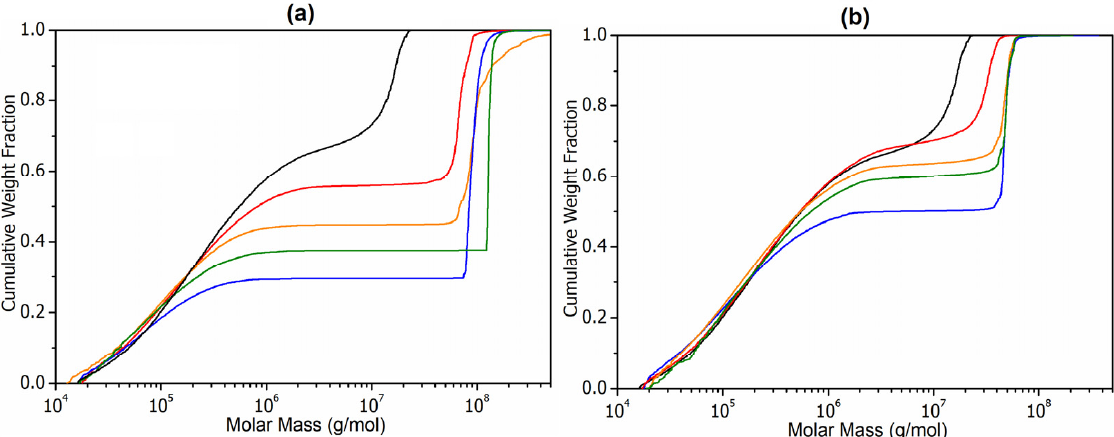
Figure 5. Cumulative molar mass distribution curves of latex copolymers modified with AME_RO ( a ) and AME_OA ( b ): reference copolymer (black), 5 wt. % (red), 10 wt. % (orange), 15 wt. % (green), and 20 wt. % (blue) of the respective bio-based monomer.